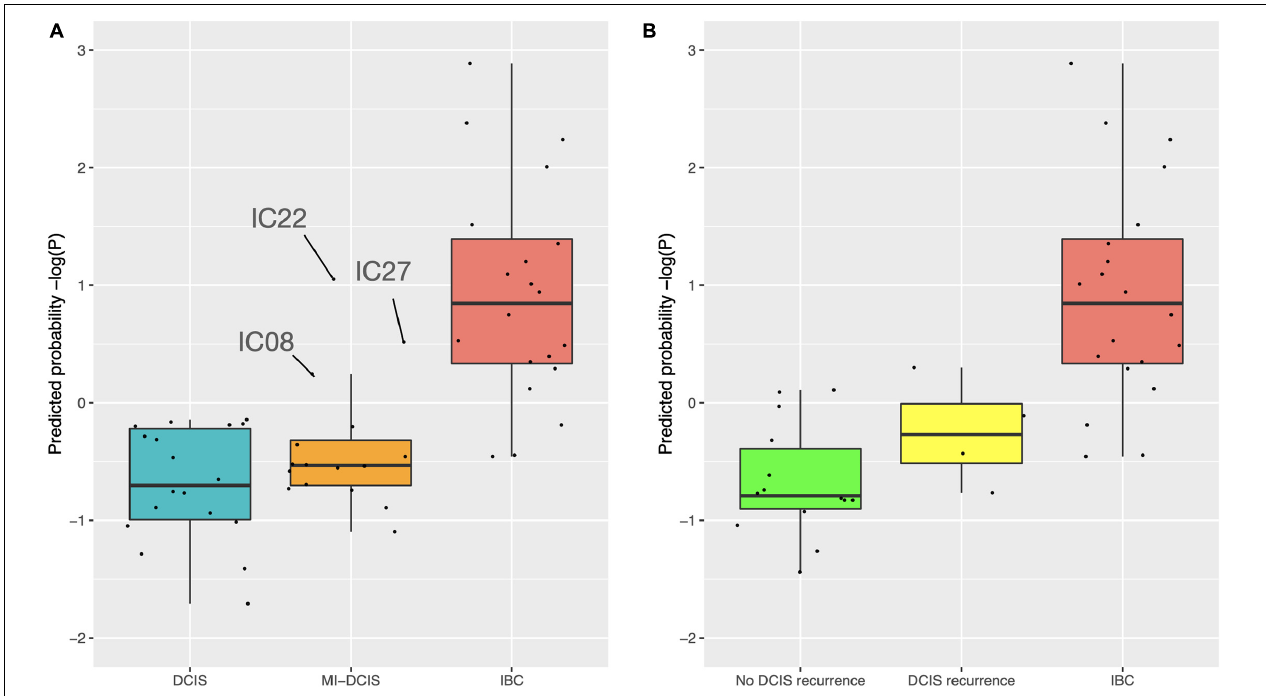
FIGURE 7 | Predicted class probabilities of the validation cohort samples. (A) The probabilities were calculated based on the 10-gene Lasso model estimated on the full training data. The validation cohort included 18 pure DCIS cases, 20 IBC cases, and 16 micro-invasive (MI) DCIS cases. Note: y-axis is log-scaled for better visualization. The non-logged version is shown in Supplementary Figure 8 . (B) The probabilities were calculated based on the six microenvironment related genes. The validation cohort included 14 DCIS cases without recurrence, four DCIS recurrence cases, and 20 IBC cases. The y-axes are z-scaled for better comparability of the prediction probabilities. The horizontal lines in the boxplots indicate median values, the whiskers the interquartile range (IQR) of the cases in each class, and the error bars show cases withing 1.5xIQR, while the remaining cases are considered